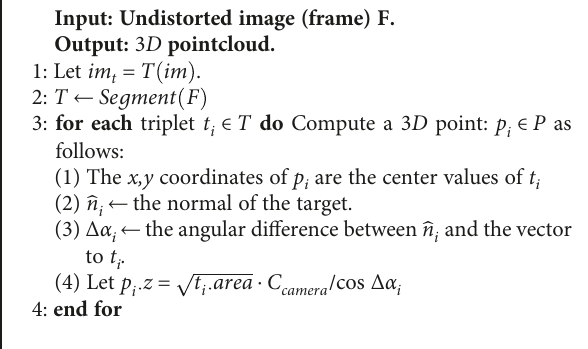
Algorithm 1: Initial 3D mapping using circular